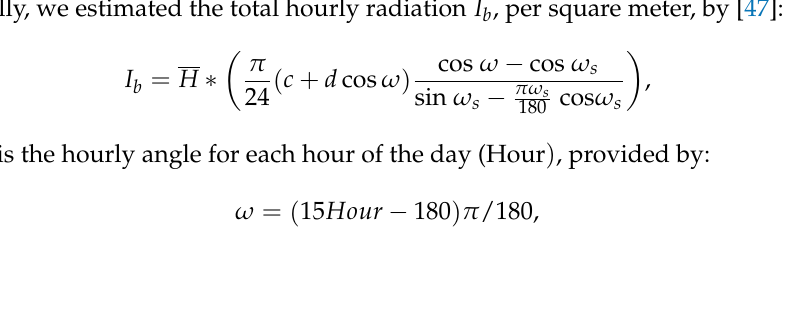
, per square meter, by [47]: 𝐼𝐼 𝑏𝑏